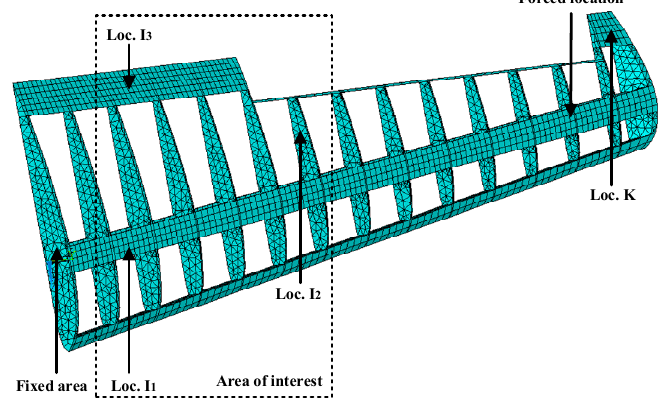
Figure 8. FE model of the simplified airfoil structure.